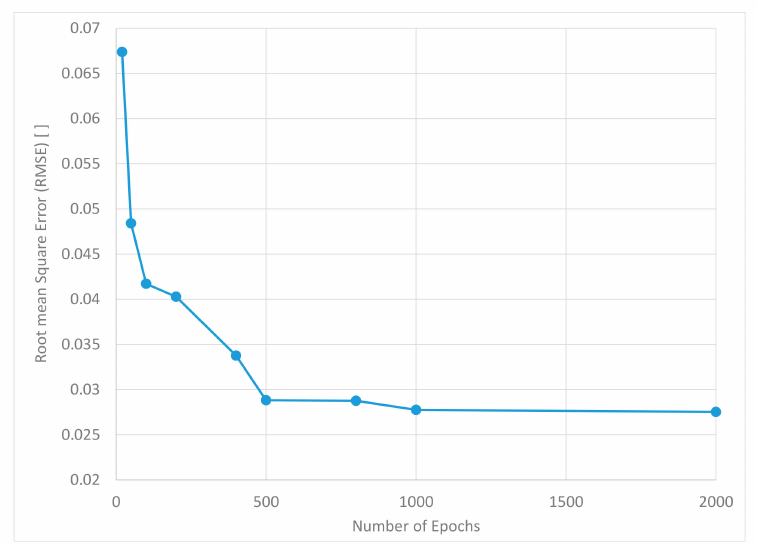
Figure 16. Training progress of deep feed-forward neural network after 20–2000 epochs, as seen by the prediction RMSE for 2022.